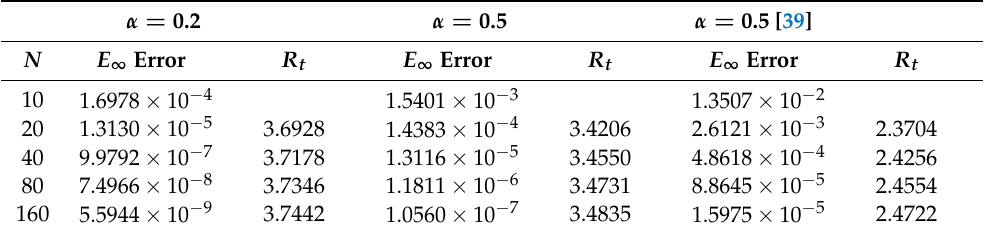
Table 2. E ∞ errors and convergence rates R t for Example 1, when ζ ( t ) = t , ω ( t ) = e t , with different α s.